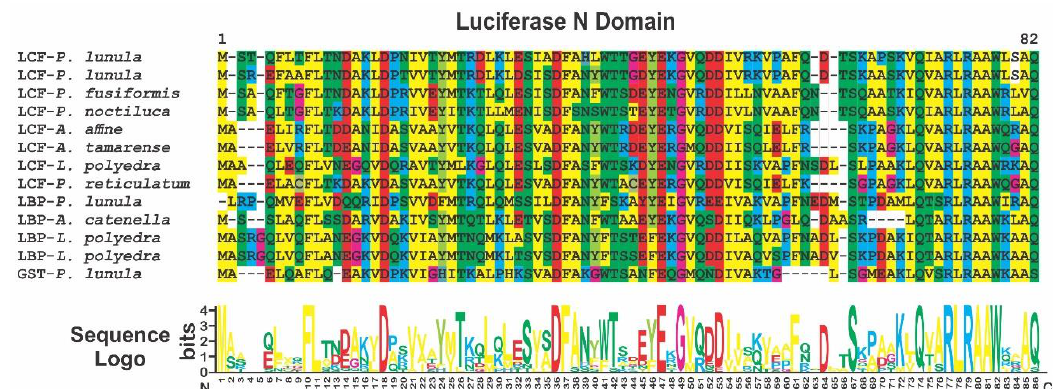
Figure 8. Sequence alignment of the luciferase/LBP N terminal domain contained in the LCF, LBP and GST from the species of the genera Alexandrium , Lingulodinium , Pyrocystis and Protoceratium that have their protein published in GenBank. Coloring of the amino acids was made according to the same pattern displayed in MEGA7 software. Sequence logo was made using WebLogo, as described in the text.